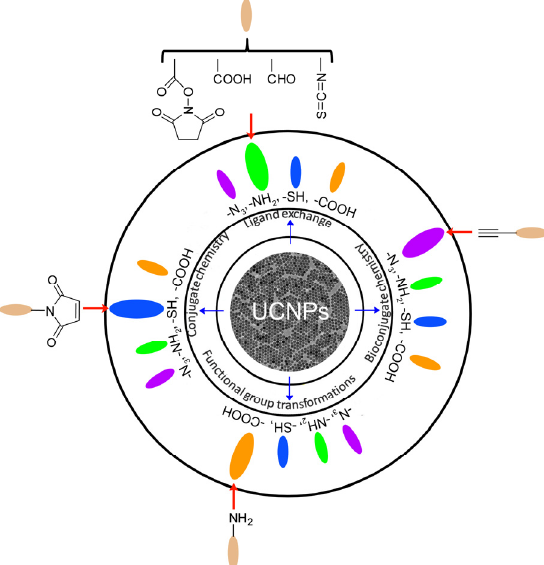
Figure 2. Surface functionalization of UCNPs and their functional groups for biological applications. Adapted with permission and modified from references [27–31]. Copyright: Royal Society of Chemistry,